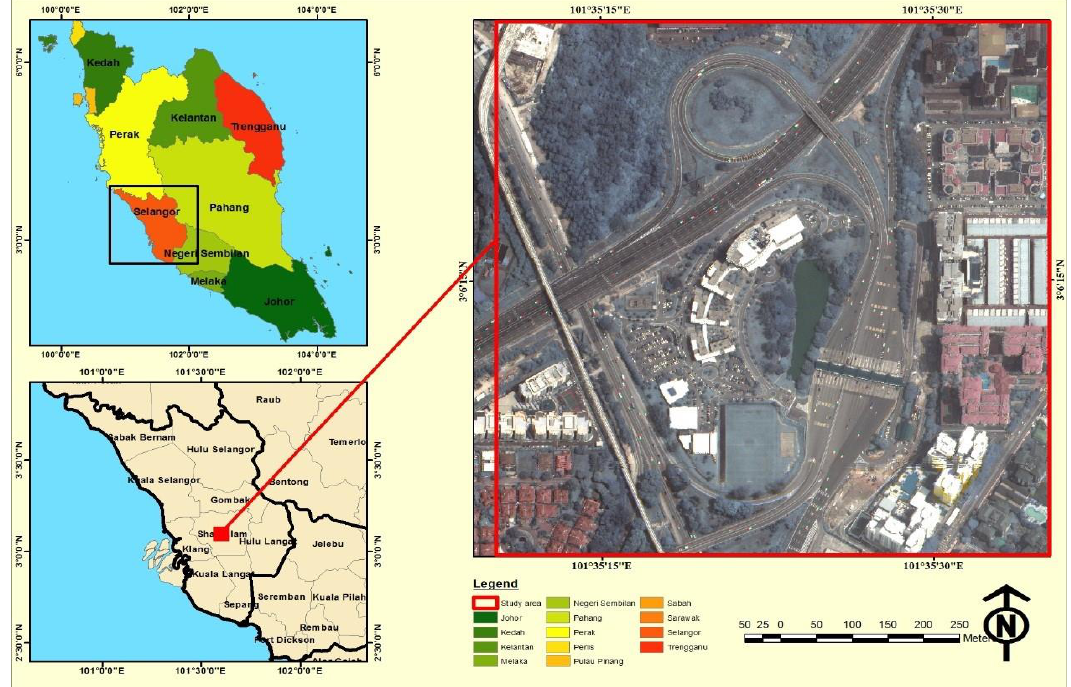
Figure 1. Location map of the study area.